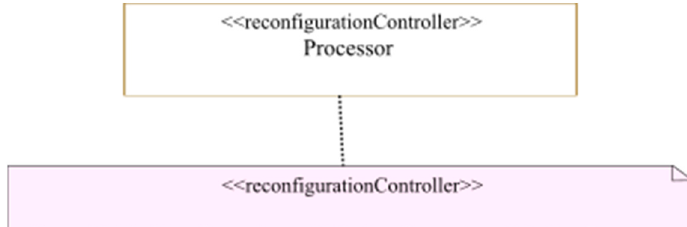
Figure 13. Allocation of the reconfigurable estimator task (the GS mode).